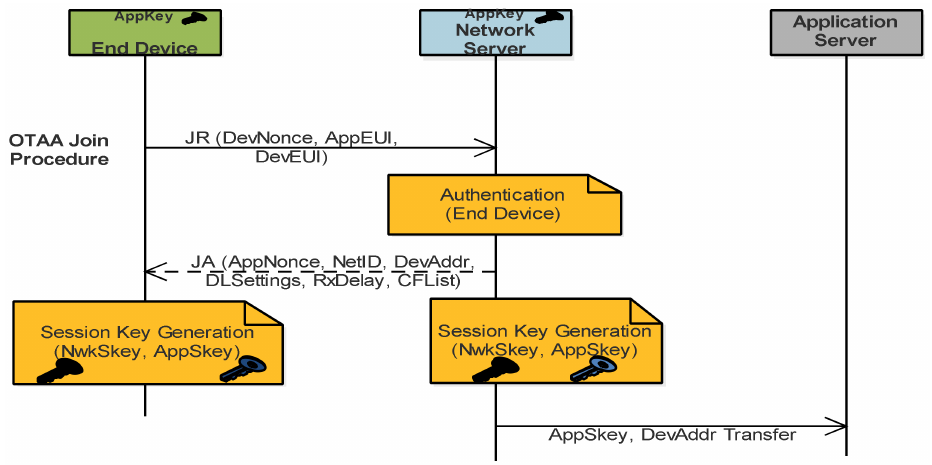
Figure 5. Figure LoRaWAN Over The Air Activation